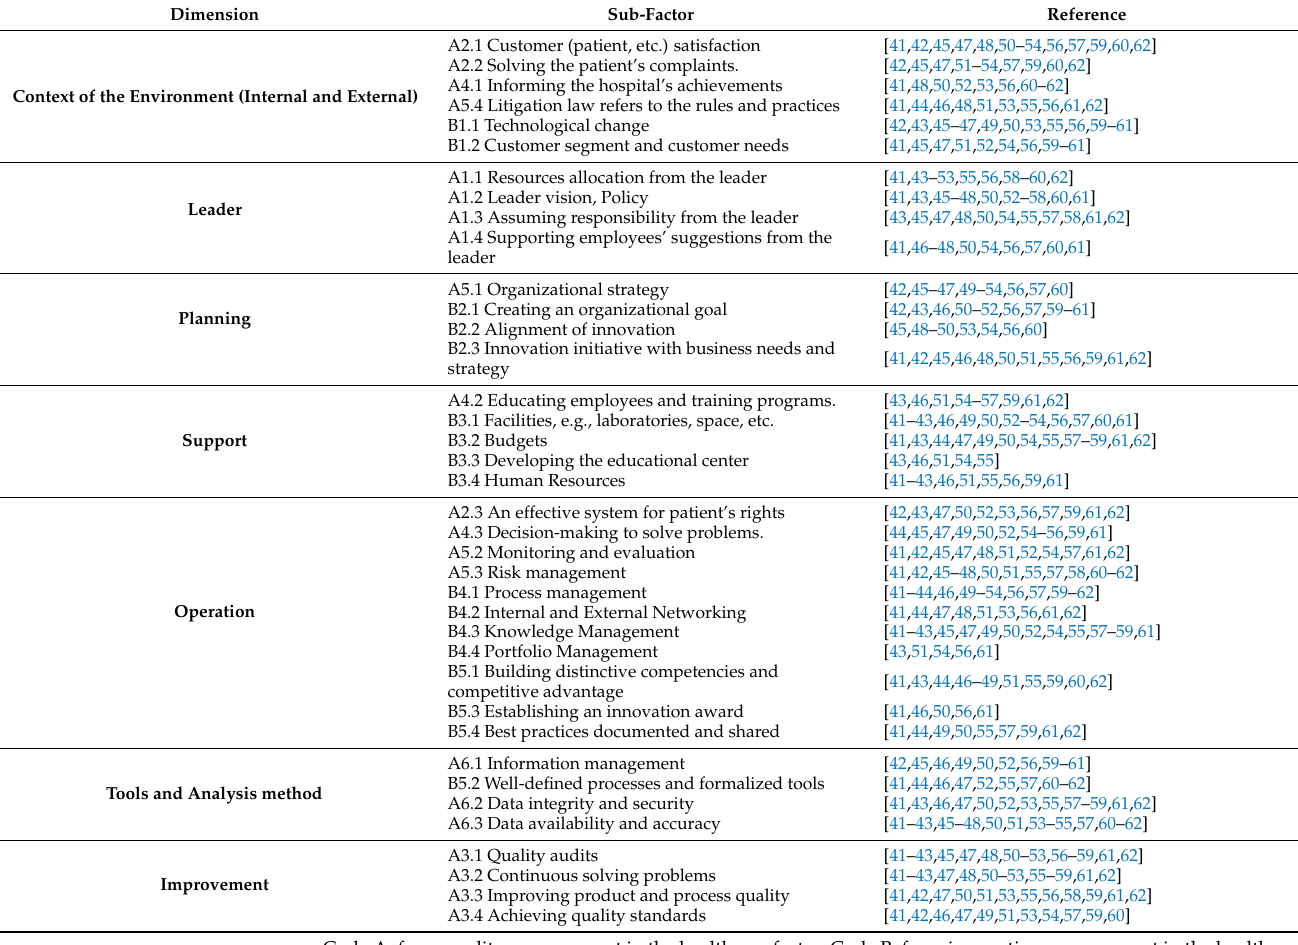
Table 2. Total quality and innovation management in healthcare